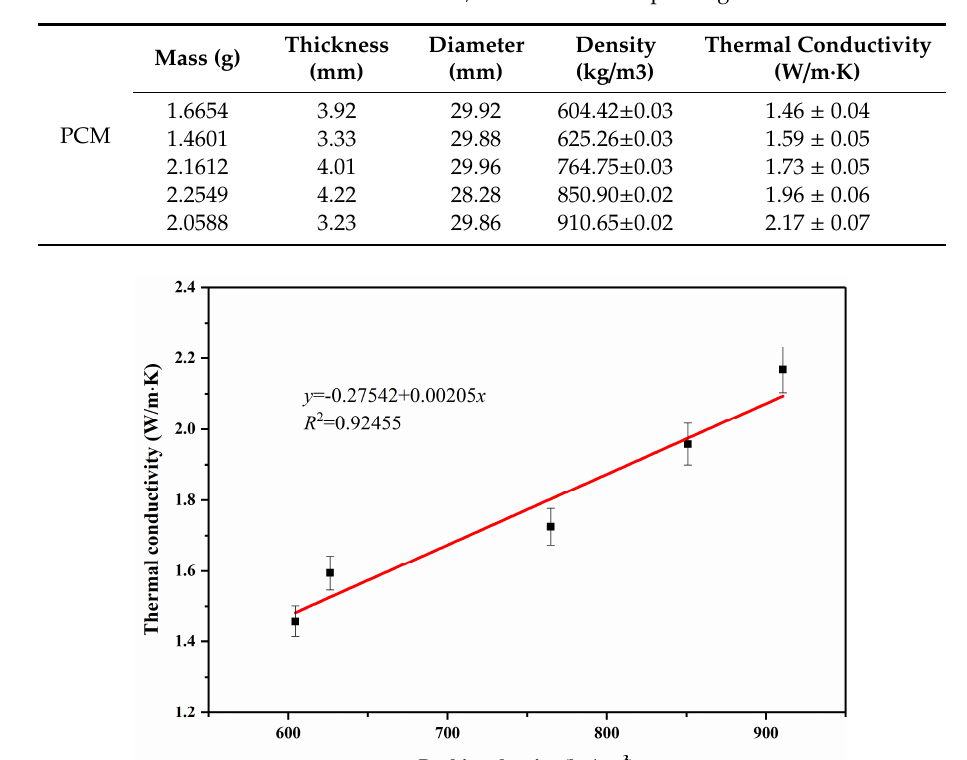
Figure 4. Melting ( a ) and freezing ( b ) graphs of CA–MA and CA–MA/EG. Table 3. Parameters of CA–MA/EG with different packing densities.